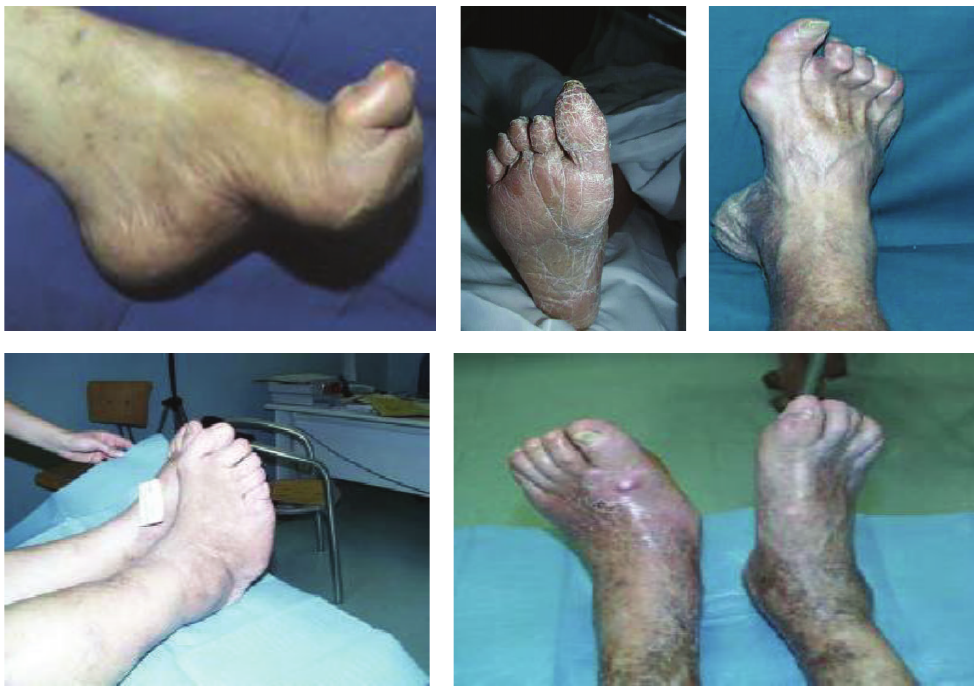
Figure 1: Neuropathic diabetic foot.